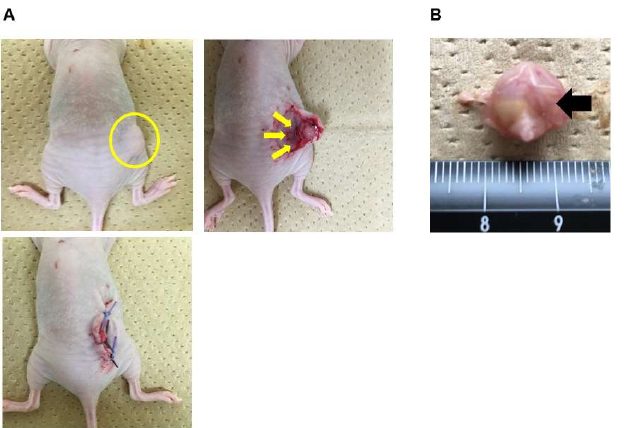
Figure 1. Representative surgical procedures. ( A ) Confirmation that the tumor’s length reached 10 mm after implantation (yellow circle), a subcutaneous incision was made in the mice under anesthesia, and polyurethane flat films without pores or polyurethane HCFs with small (5–8 μm), medium (8–12 μm), or large (12–16 μm) pores were applied under the surface of the formed tumor (yellow arrow), and the skin was sutured. ( B ) During tumor removal, the HCFs (black arrow) were affixed to the tumor surface.